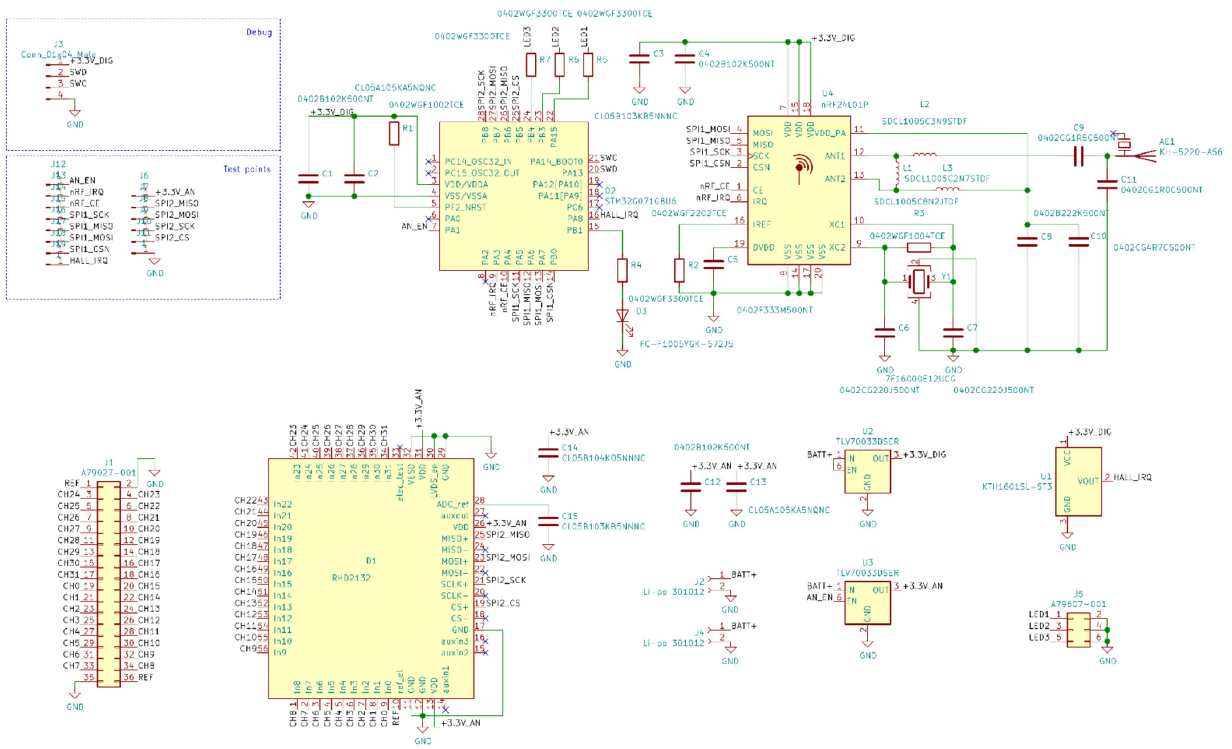
Figure A1. Wireless module electrical schematic diagrams.